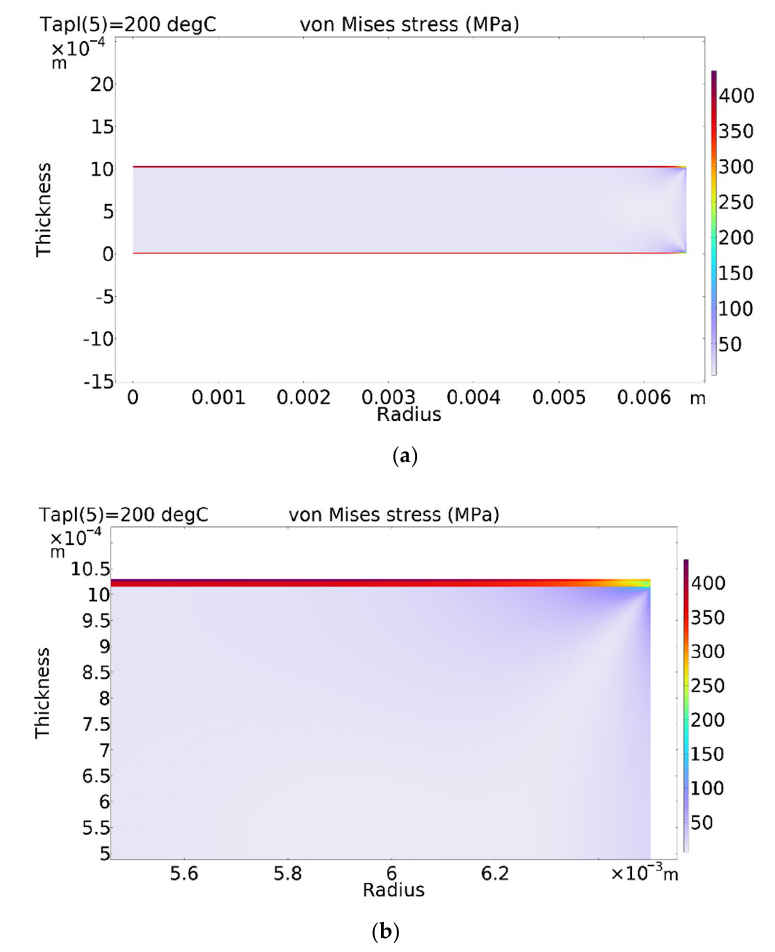
Figure 4. Distribution of von Mises stress in piezoelectric disc at 200 °C temperature: ( a ) full view; ( b ) zoomed edge of the top layer.